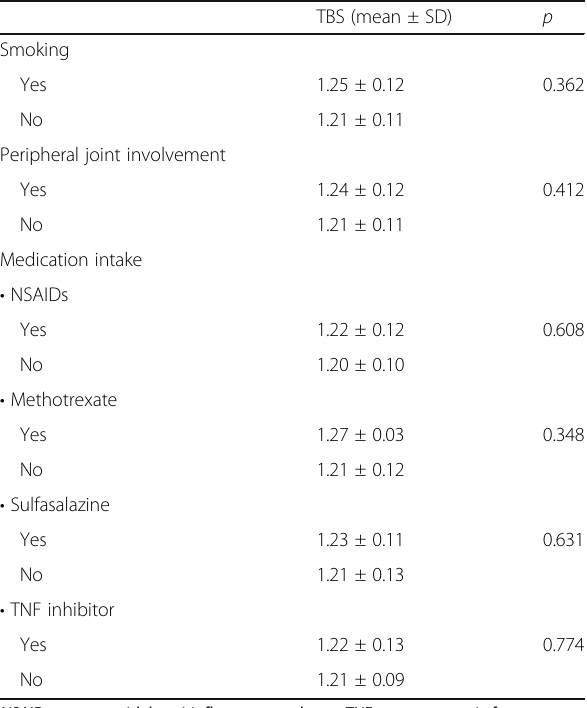
Table 5 Comparison of the TBS in patients with and without smoking, peripheral joint involvement and drug intake in AS